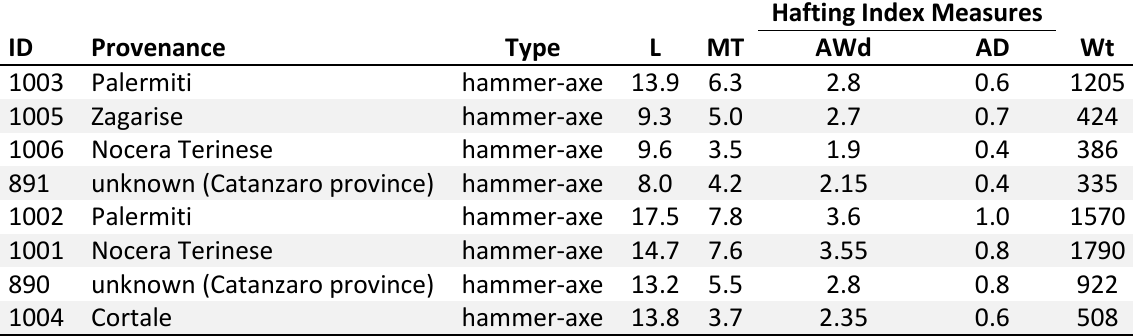
Table 1. ID and quantitative data of the eight grooved tools kept in the Museo Archeologico Provinciale in Catanzaro. Abbreviations: L - length (cm); MT - maximum thickness (cm); AWd - average width (cm); AD - average depth (cm); Wt - weight (grams).